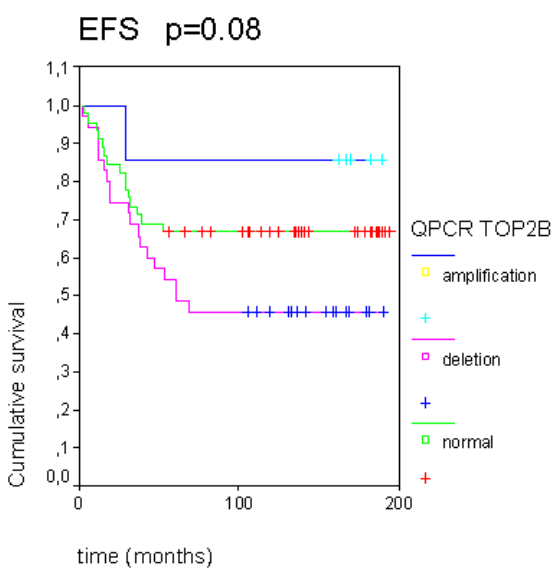
Figure 2. The TOP2B gene copy variations seem to have an impact on event-free survival (EFS) in this pediatric osteosarcoma population.